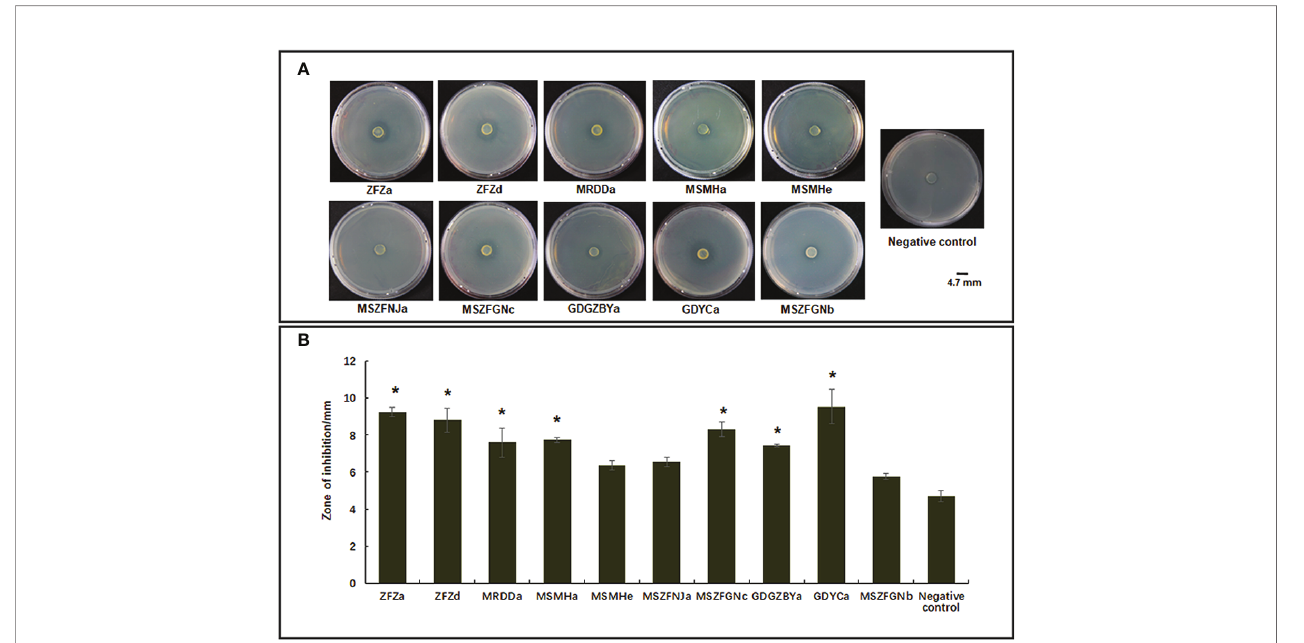
FIGURE 3 | Anti- Xoo activities of the endophytic strains isolated from BB-diseased rice leaves. (A) Representative results of zone of inhibition tests. (B) Diameter of zone of inhibition. The error bar represents standard deviation for three independent replicates. NC, negative control. * indicates p < 0.05 by